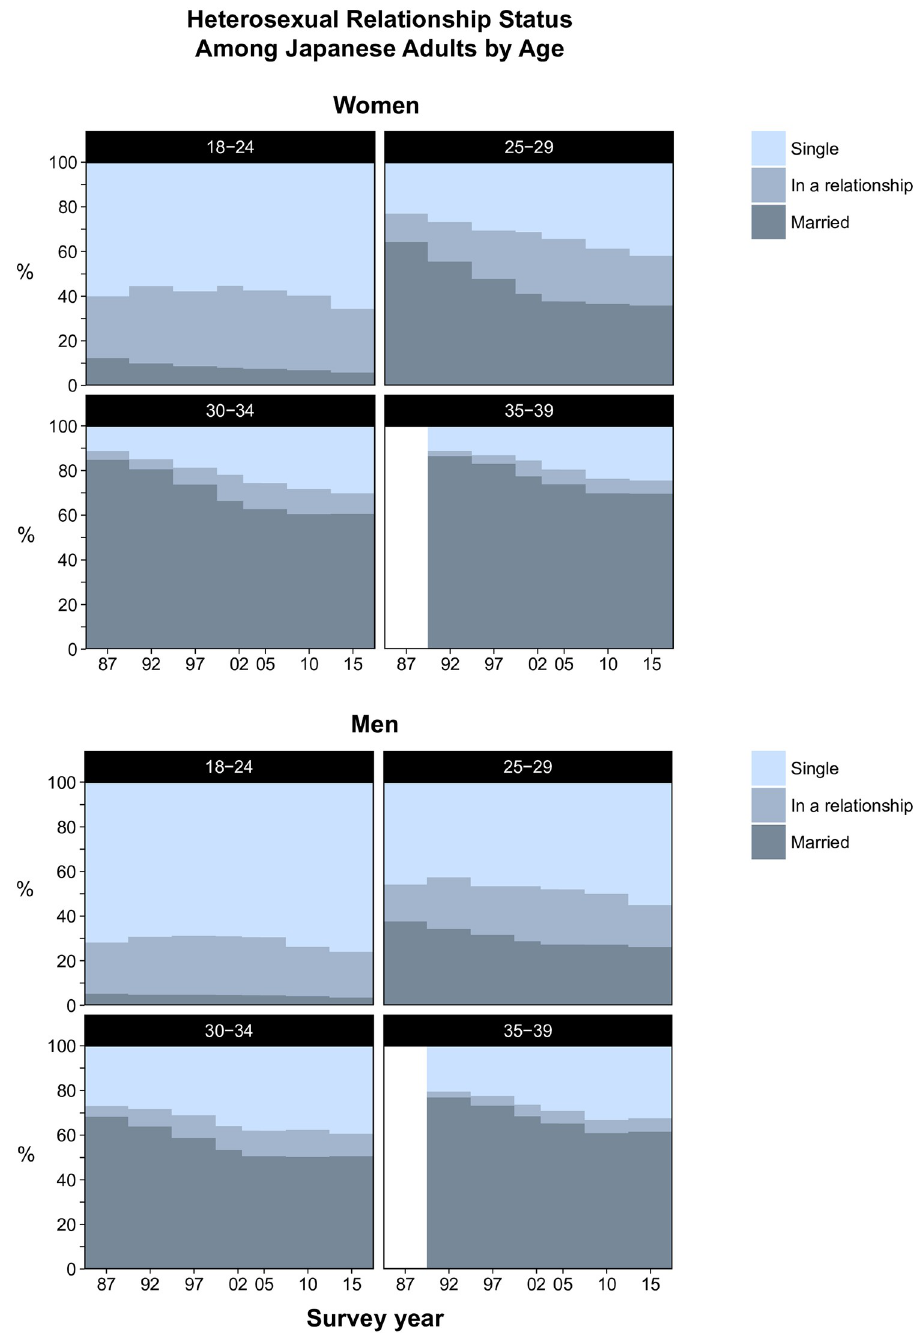
Fig 2. Trends in heterosexual relationships status among Japanese women and men by age group, 1987–2015. Proportions in 1987–2010 were standardized to the age distribution of 2015. When analyzed by age group, the proportion who were single increased only slightly among both women (60.0% in 1987 vs. 65.6% in 2015; aOR 1.007 [1.003–1.011], absolute increase per 10 years, 2.0%) and men (71.8% vs. 75.9%; aOR 1.008 [1.003–1.012], absolute increase per 10 years, 1.5%) aged 18–24 years. Among women, the proportion single steadily